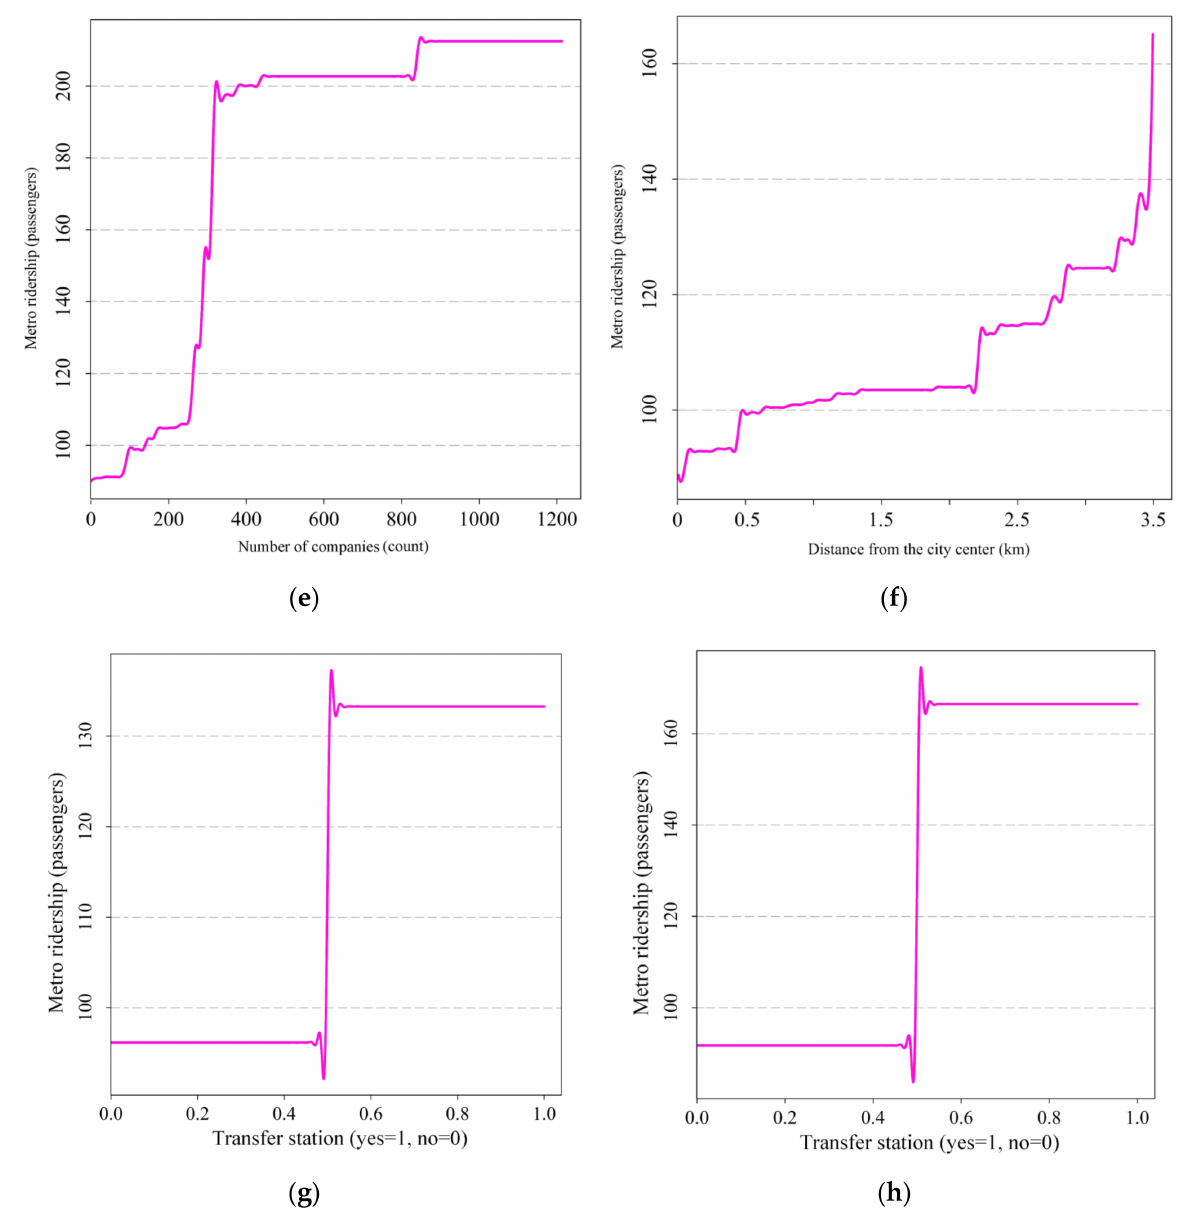
Figure 2. Nonlinear impact of built environment on metro ridership. ( a ) Distance to the city cen- ter (origin). ( b ) Number of companies (origin). ( c ) Floor area ratio (destination). ( d ) Floor area ratio (origin). ( e ) Number of companies (destination). ( f ) Distance to the city center (destination). ( g ) Transfer station (origin). ( h ) Transfer station